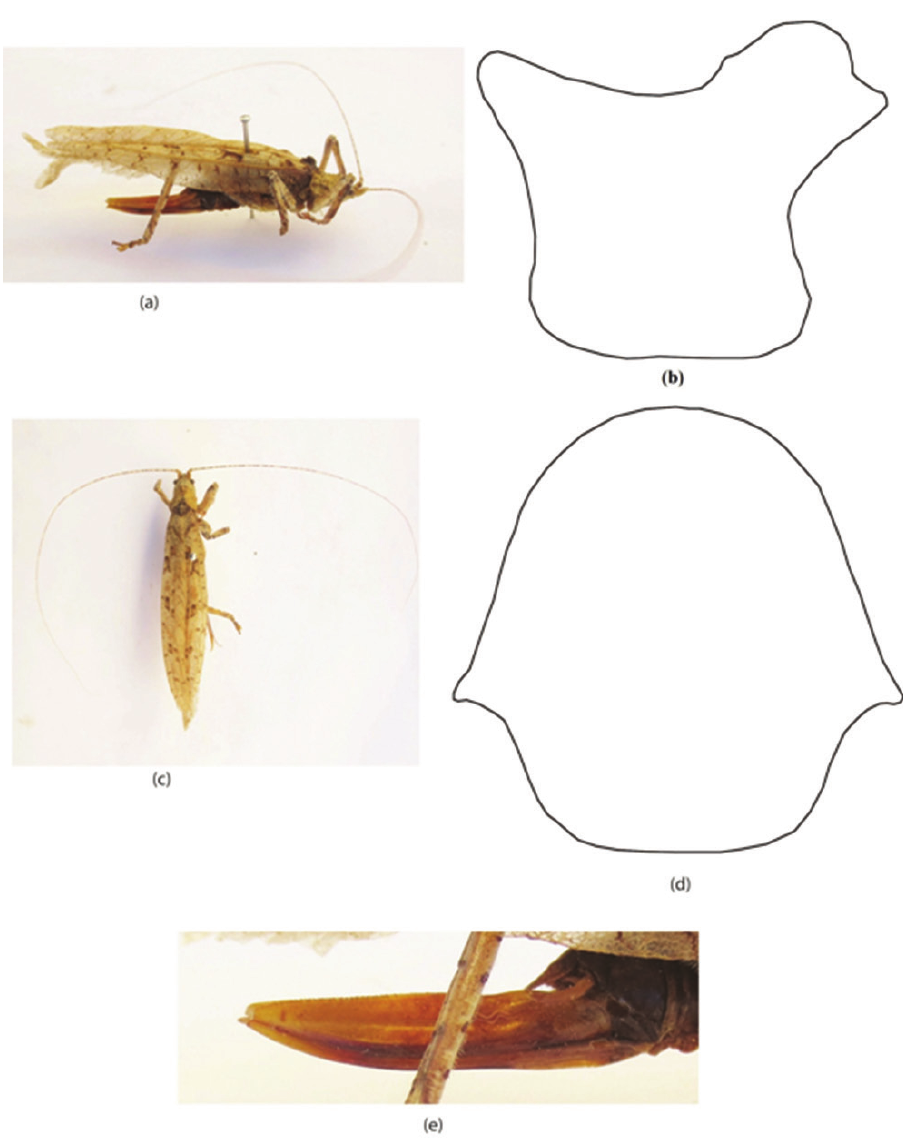
Figure 3. Sathrophyllia saeedi sp. n. female a adult LV b pronotum LV c adult DV d pronotum DV e ovipositor